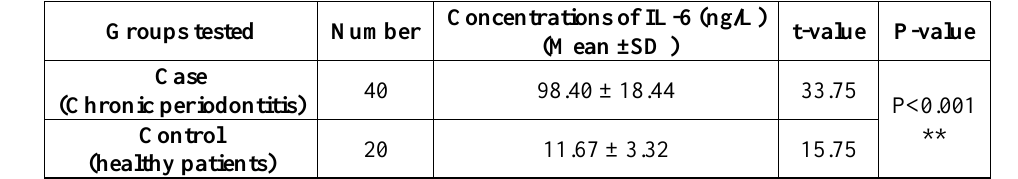
Table 1: Comparison of Salivary IL-6 level (ng/L) between Chronic Periodontitis Patients and